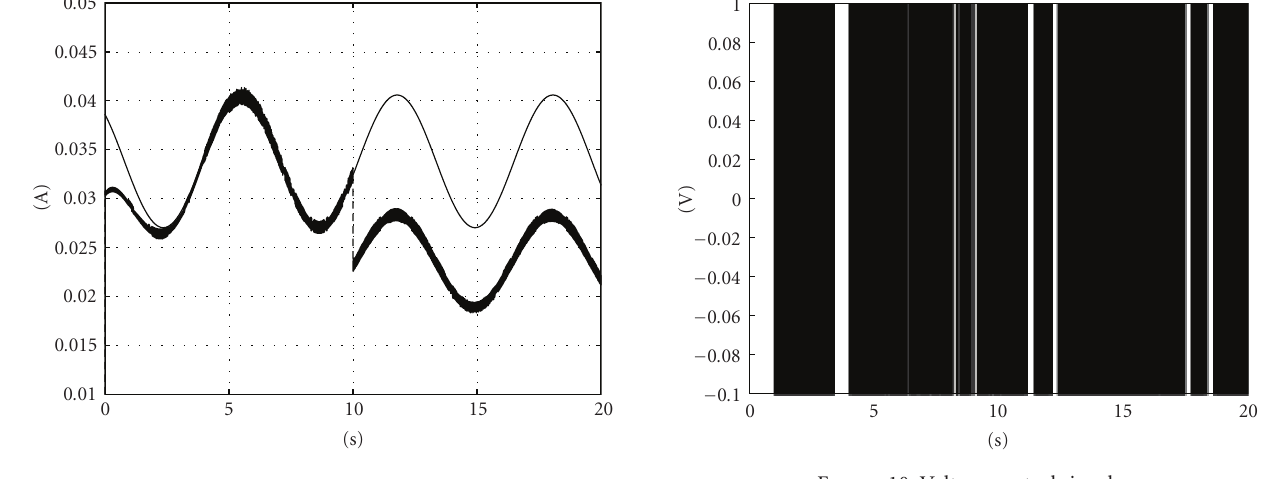
Figure 10: Voltage control